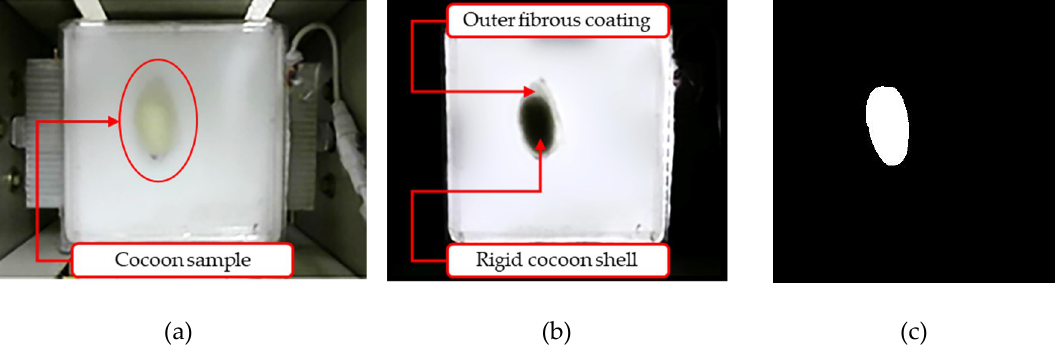
Figure 9. ( a ) RGB image of the cocoon on flip plate captured by FEM camera without backlight, ( b ) RGB image of the cocoon on flip plate captured by FEM camera with backlight illumination, and ( c ) binarized image of the cocoon shell with fibrous outer surface removed.